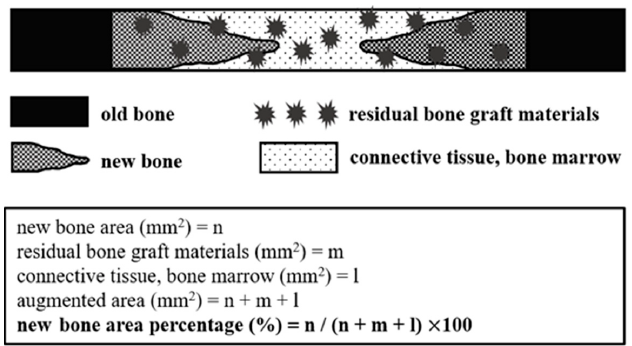
Figure 4. Schematic drawing showing the histometric analysis.